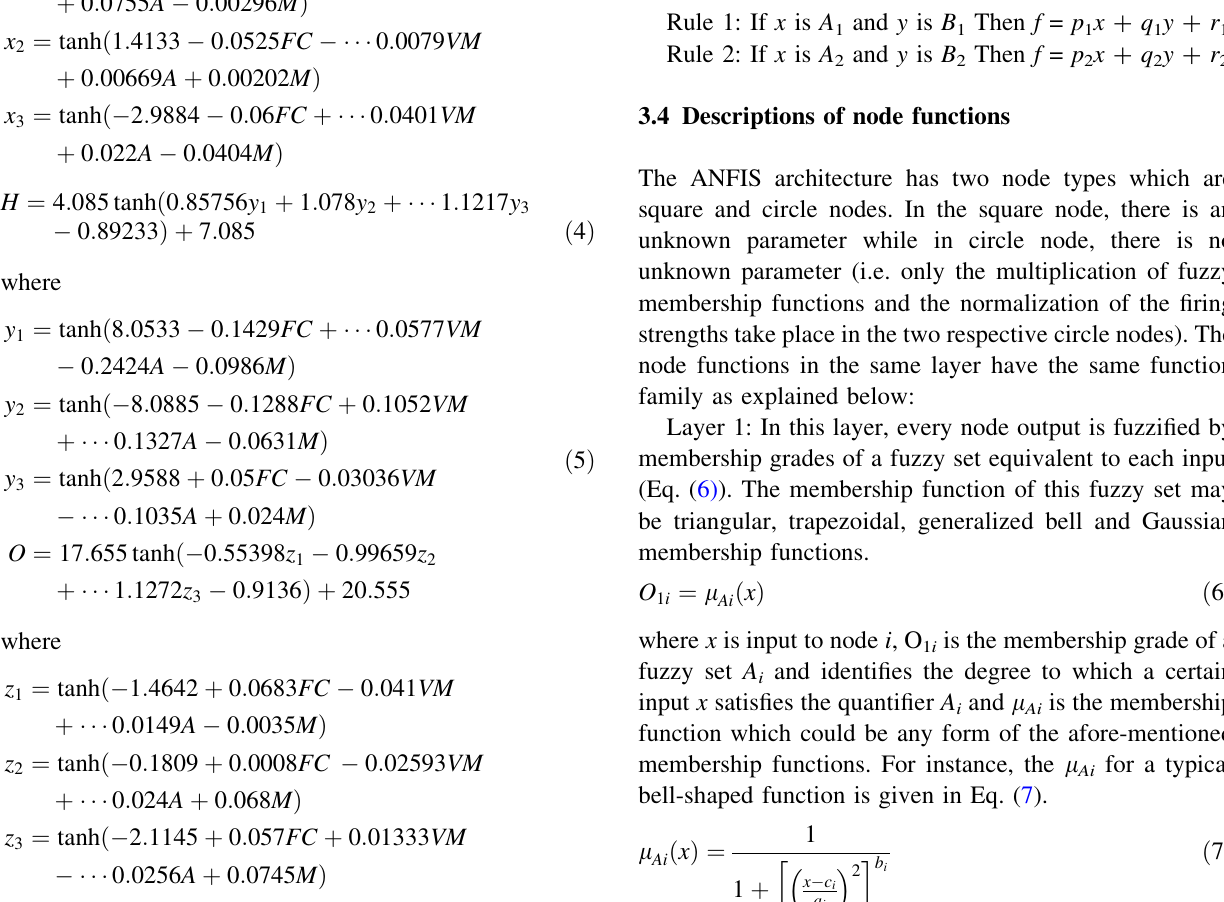
Fig. 5 (Rafiei-Sardooi et al. 2018; Seifi and Riahi 2018). Its rules